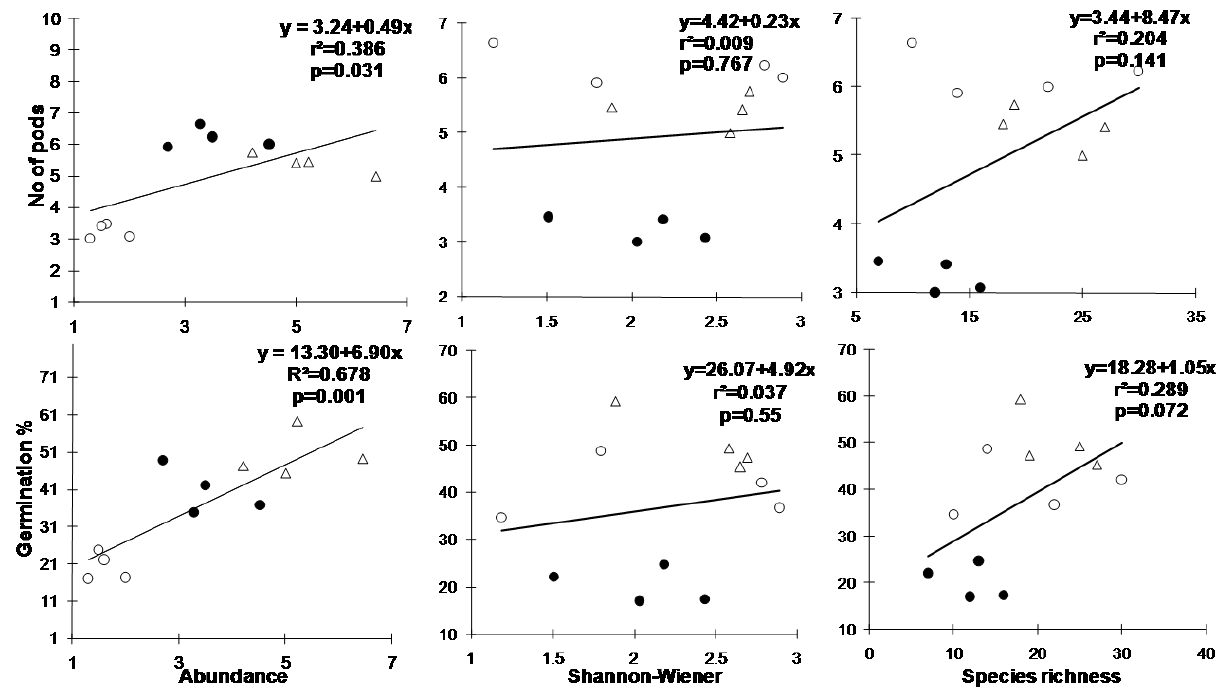
F IGURE 4. Relationship between flower visitor abundance, species richness and diversity (Shannon-Wiener) and plant reproductive performance measured as germination % (lower graphs) and fructification (number of pods, upper graphs) in P. juliflora at southern Punjab, Pakistan. Open triangles: Pirowal; Open circles: Chichawatni; Solid circles: